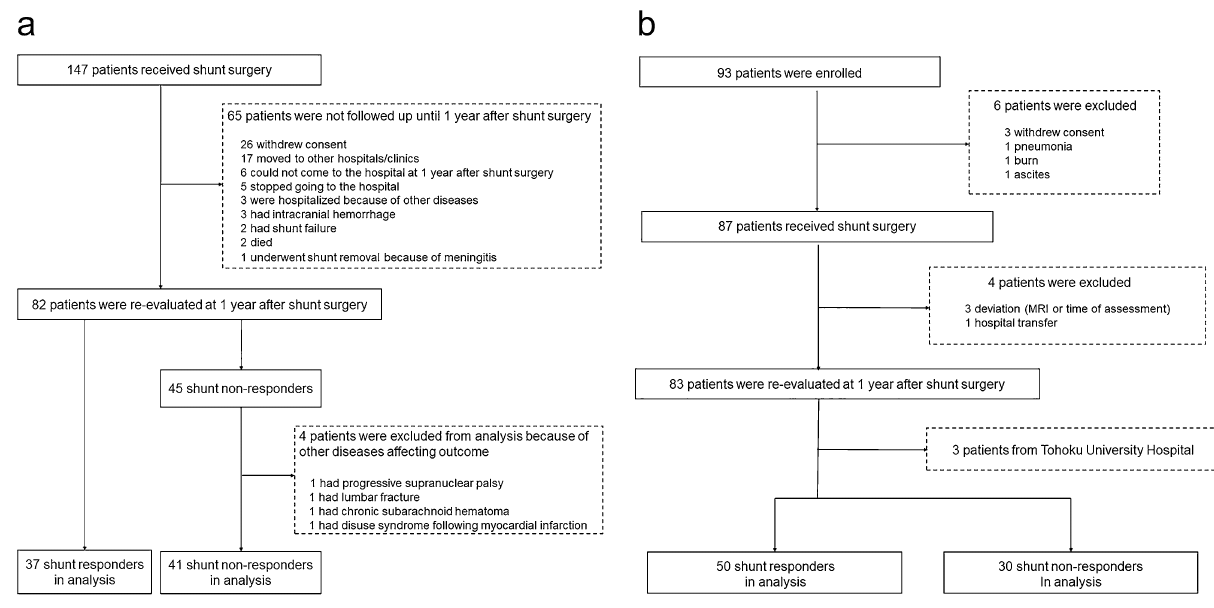
Figure 1. Patient flow charts in Tohoku University Hospital ( a ) and a multicentre prospective trial of lumboperitoneal (LP) shunt surgery for patients with iNPH (SINPHONI-2) ( b